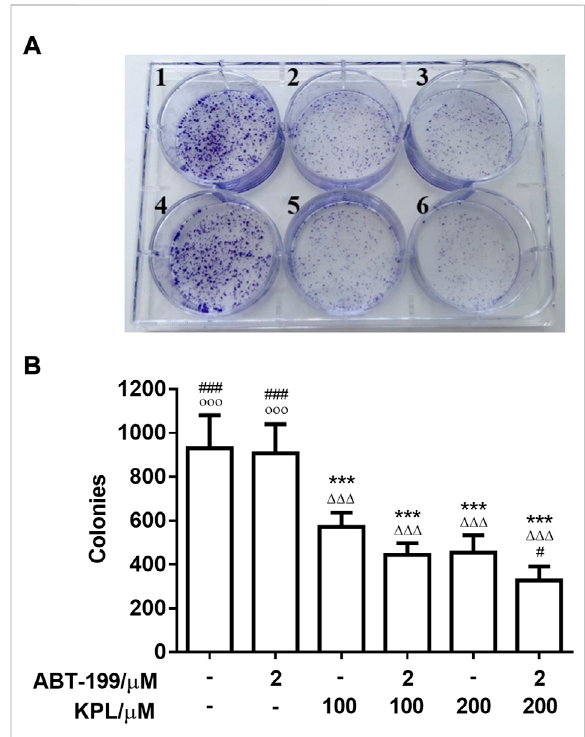
The experimental results of clone formation of HepG2 cells treatedwithKPLandABT-199for 24 h. (A) Colonyformationassay was conducted to investigate growth in vitro after treatment with KPL at the concentration of 100 and 200 μ M alone or combined with ABT-199 at 2 μ M for 14 days. The colonies were visualized with the images. 1: Negative control, 2: KPL 100 μ M,